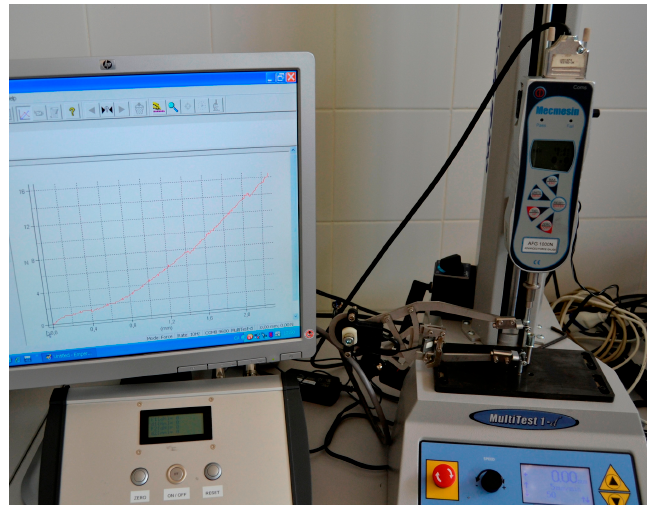
Figure 6. Verification test setup for force and distance deviation.